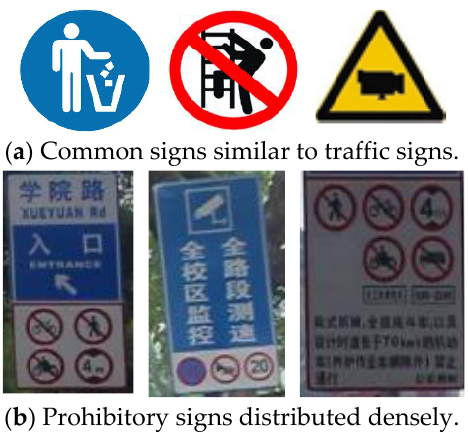
Figure 7. Examples that are difficult to identify.